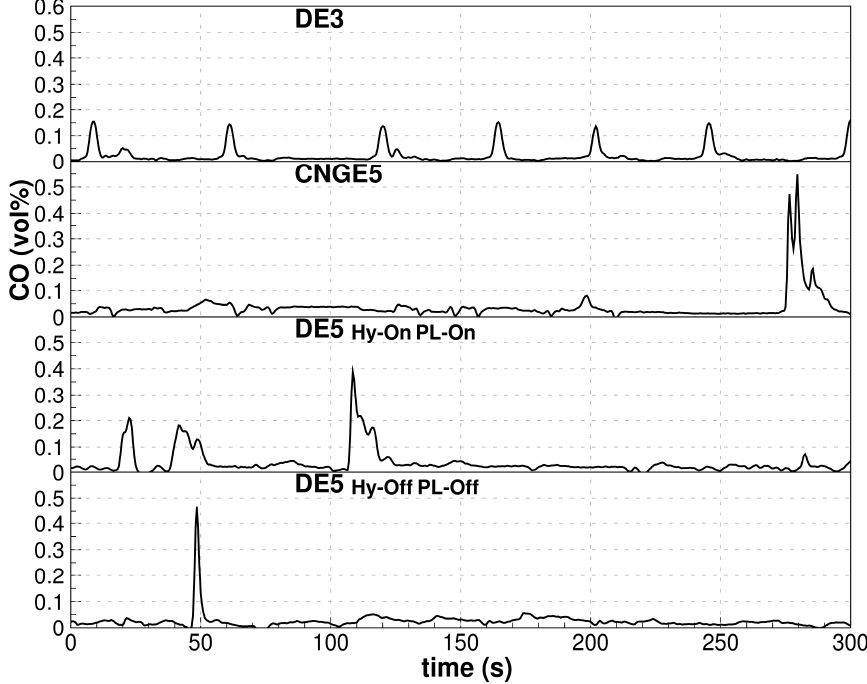
Figure 8. CO concentration vs time measured of the DE3 bus, CNGE5 bus, and DE5 bus in hybrid mode with power limiter on and in non-hybrid mode with power limiter off.